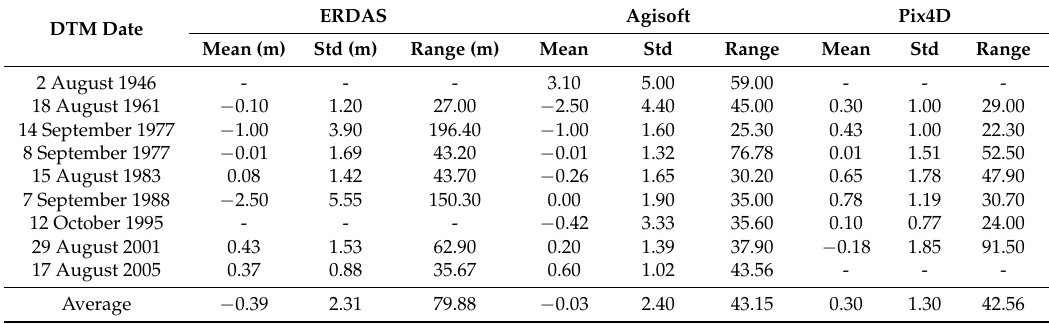
Table 3. Stable terrain statistics for each DTM. The standard deviation serves as accuracy measure.